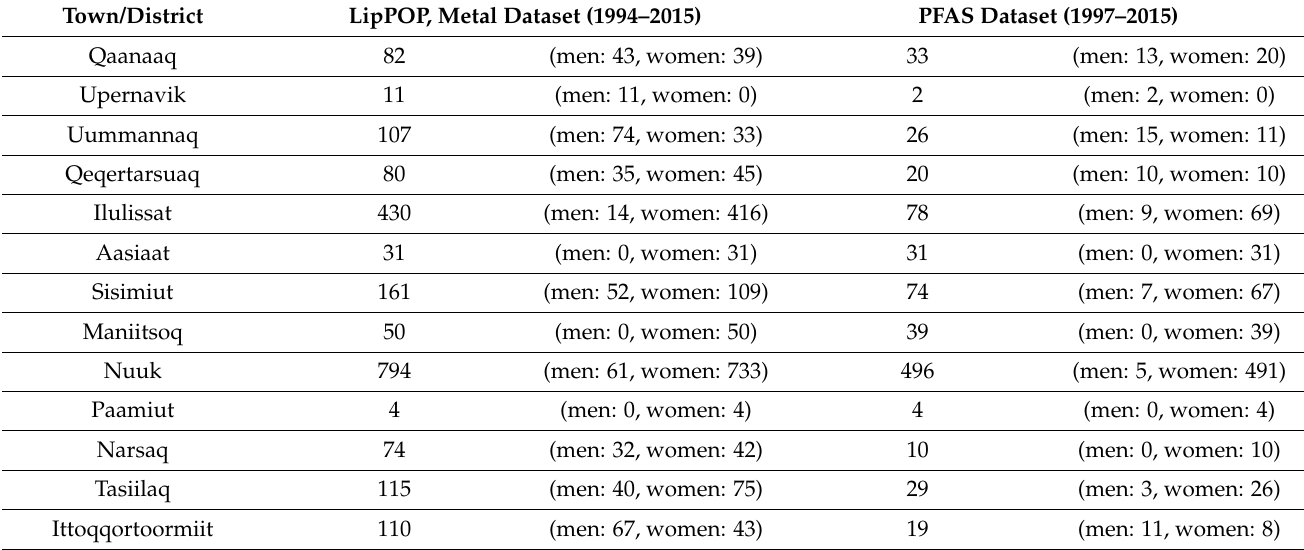
Table 1. The sample number of study population in Greenland during 1994–2015.